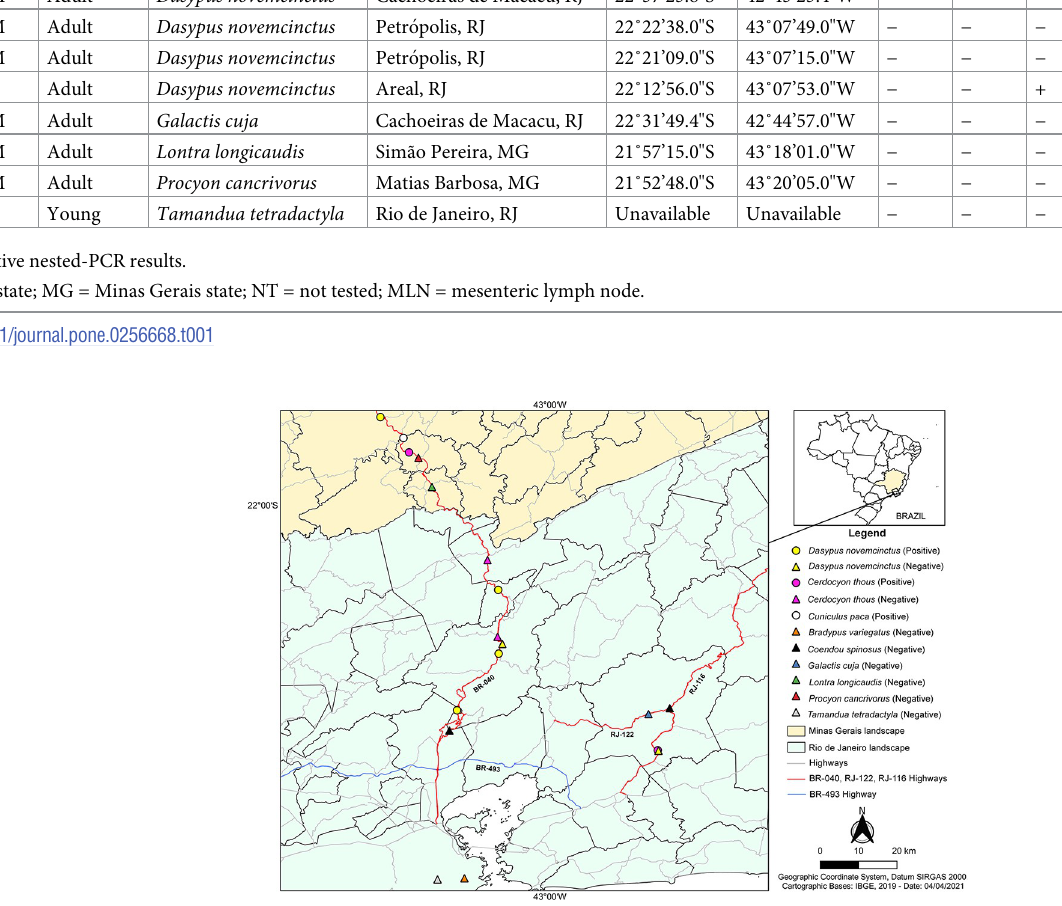
Fig 1. Detection of Paracoccidioides brasiliensis in wild animals from this study. Road-killed animals from three highroads in Rio de Janeiro (green) and Minas Gerais (yellow) states were studied. The dark gray lines represent the municipalities’ boundaries, while the light gray lines represent the main highroads of these states. The GPS coordinates of animals’ collection sites are represented by symbols. The color of symbols represents the animal species studied: Dasypus novemcinctus (yellow), Cerdocyon thous (pink), Cuniculus paca (white), Bradypus variegatus (orange), Coendou spinosus (black), Galactis cuja (blue), Lontra longicaudis (green), Procyon cancrivorus (red), and Tamandua tetradactyla (gray). The shape of symbols represents positive (circle) and negative (triangle) nested-PCR results of each animal. Base map retrieved from the Brazilian Institute of Geography and Statistics (IBGE).